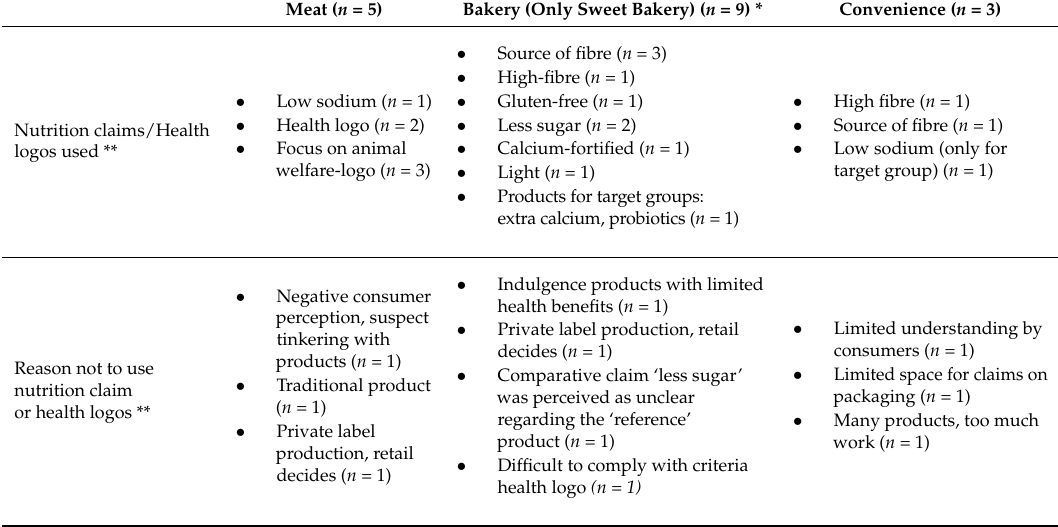
Table 4. Used nutrition claims and health logos and reasons not to use these, as mentioned in the interviews with 17 companies from the bakery ( n = 9), meat ( n = 5) and convenience ( n = 3)